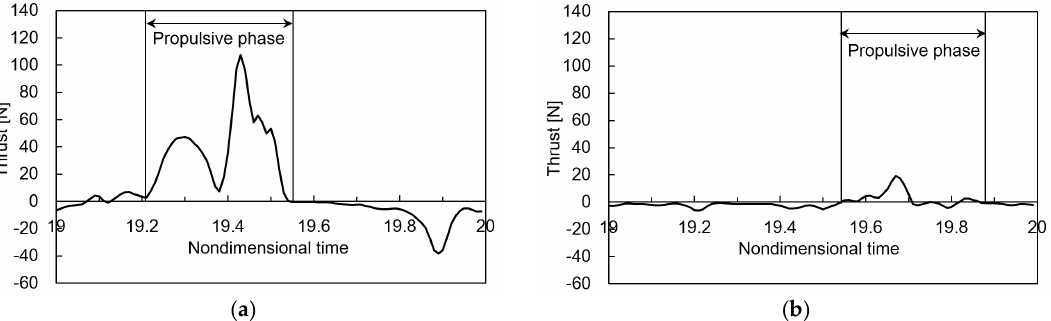
Figure 4. Time histories of thrust produced by limbs in the simulation. ( a ) Intact limb; ( b ) Deficient